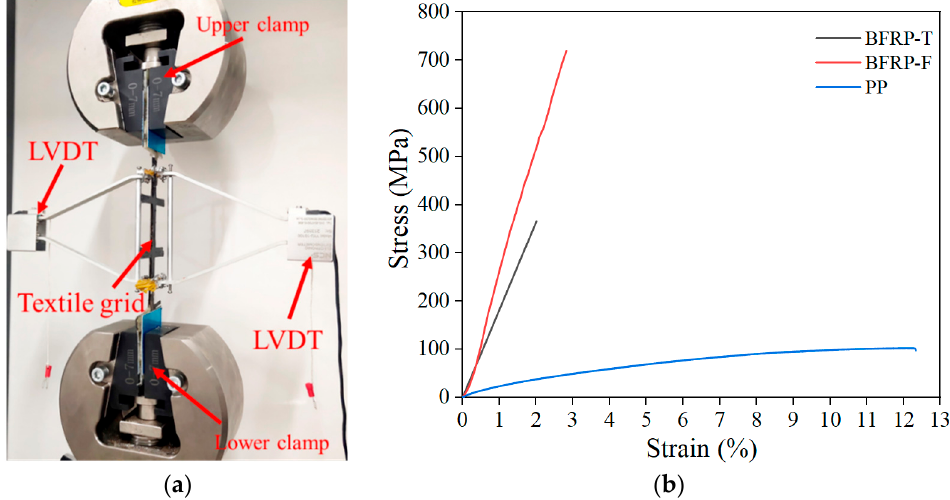
Figure 5. ( a ) Test setup; ( b ) stress–strain curves of different materials.